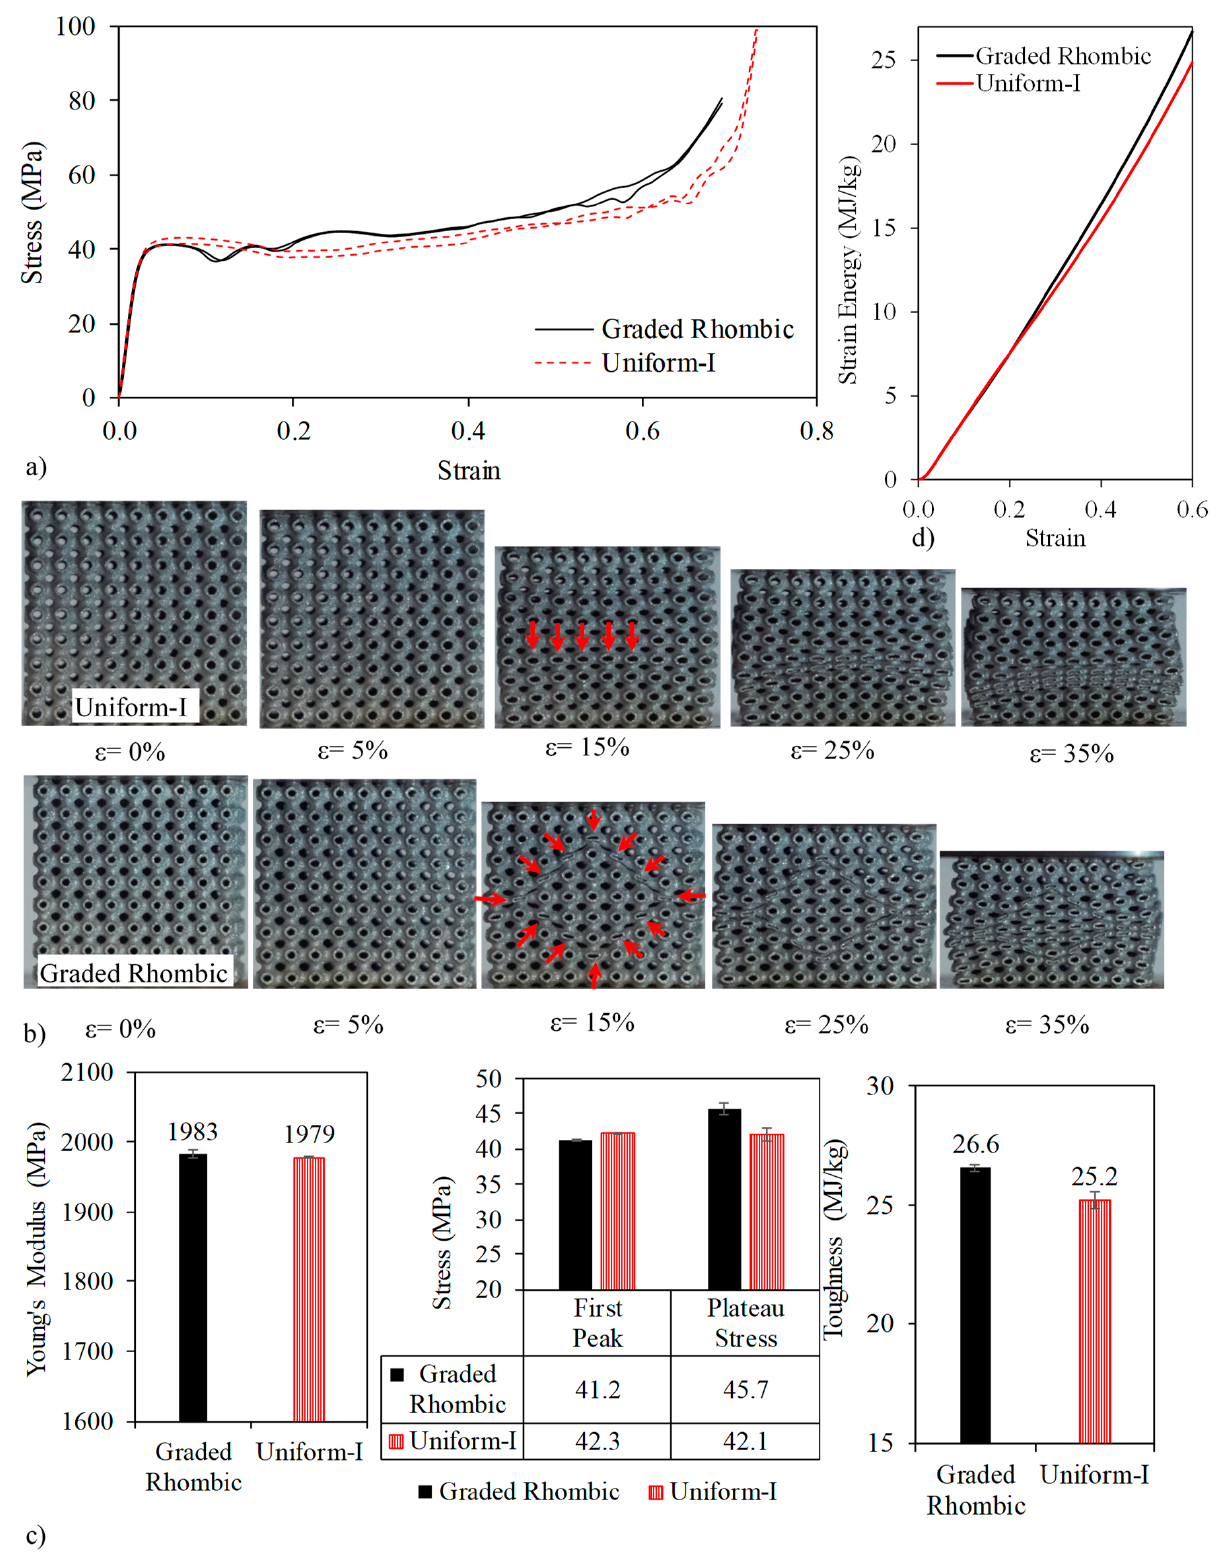
Figure 6. ( a ) Stress–strain response, ( b ) deformation pattern, ( c ) deduced mechanical properties of the graded rhombic and uniform structures, and ( d ) toughness as a function of strain level.